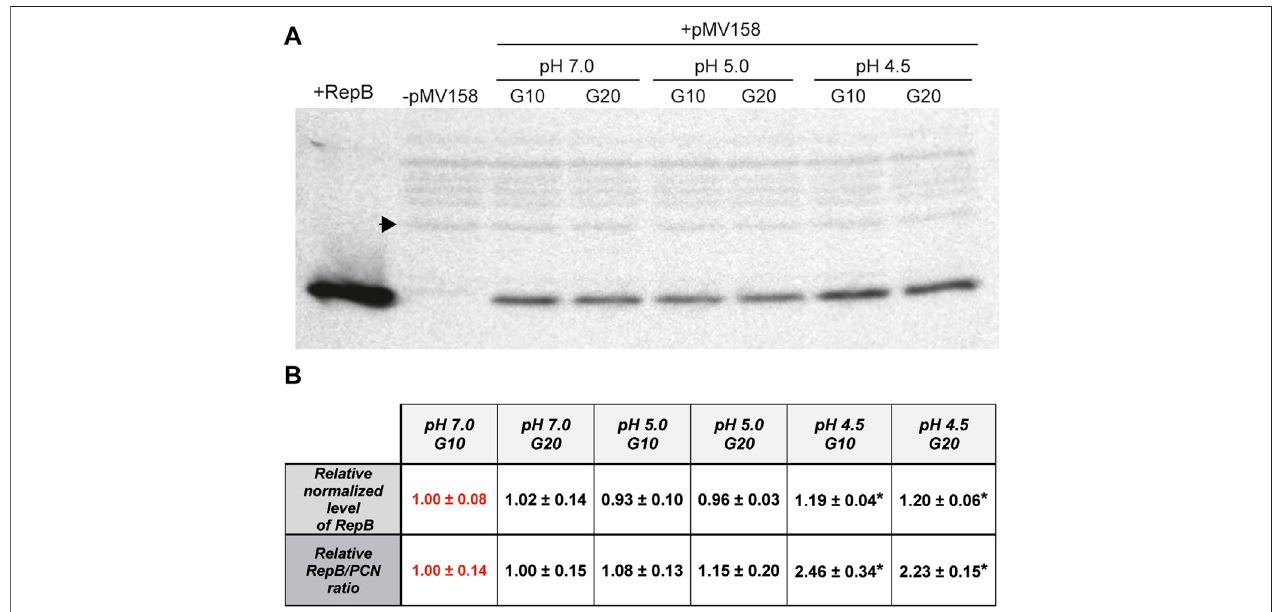
FIGURE 6 | Estimation of the relative RepB concentration and RepB to pMV158 molar ratio in lactococcal cells grown at different pHs. (A) Western blot analysis withRepBantiserumofproteinextractsfrom L.lactis /pMV158cellsgrownfor10and20generationsinTc-freeM17 ′ adjustedtopH7.0,5.0,and4.5.PureRepBprotein andaproteinextractfromapMV158-free L.lactis culture( − )wereusedascontrols.Thesamplevolumeoftheproteinextractswasadjustedinordertokeepconstantthe amountoftotalproteinloadedinthegel.Ablackarrowheadindicatesthebandusedasaninternalloadingcontrol. (B) Thenormalized RepBlevel(9.91 ± 0.77)and RepB/PCNratio(1.32 ± 0.18)weretakenasreferenceand assignedthevalue1(inredcolor)forcomparisonwiththedifferentconditions. Dataarepresented asmean ± SD of the analysis of four different western blot assays. Values with an asterisk were found to have statistically signi fi cant differences with the corresponding reference